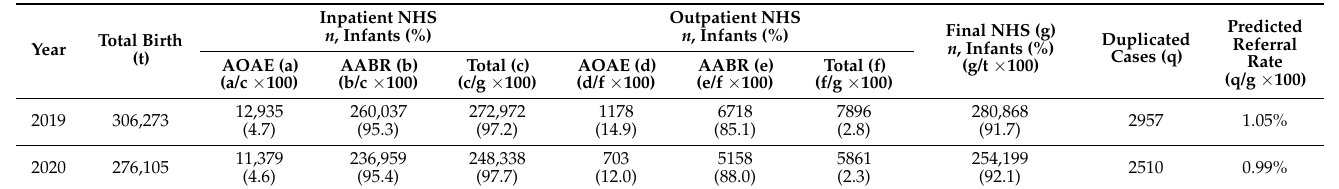
Table 1. Yearly inpatient and outpatient newborn hearing screening status compared to total birth.